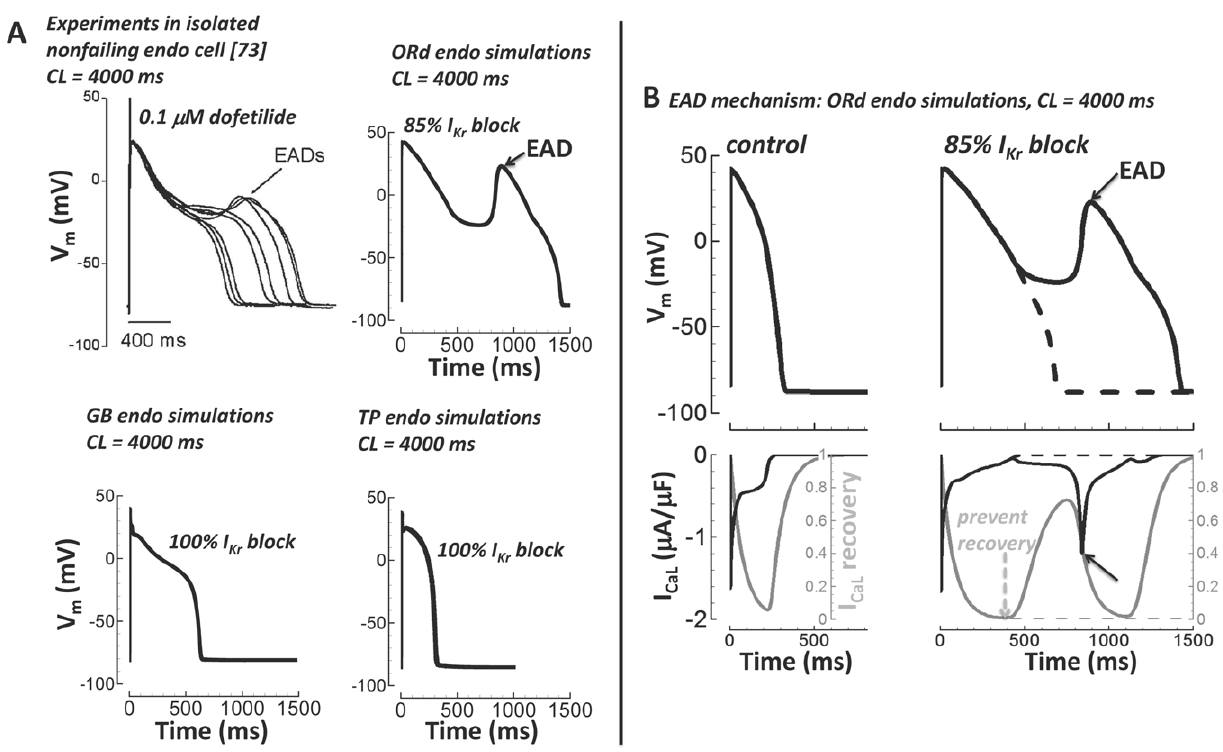
Figure 11. Early afterdepolarizations (EADs). A) Top left) Experiments in isolated nonfailing human endo myocytes from Guo et al.[73] showed EADs with slow pacing (CL=4000 ms) in the presence of I Kr block (0.1 m M dofetilide, , 85% I Kr block[74], reproduce with permission). Top right) Following the experimental protocol of Guo et al. (CL=4000 ms, 85% I Kr block) the ORd model accurately showed a single large EAD. Bottom) GB (left) and TP (right) models failed to generate EADs (CL=4000 ms, even with 100% I Kr block). B) EAD mechanism. APs are on top. I CaL (black) and I CaL recovery gate (gray) are below. Slow pacing alone (CL=4000 ms) did not cause an EAD (left). Slow pacing plus I Kr block (85%) caused an EAD (solid lines, right). The EAD was depolarized by I CaL reactivation during the slowly repolarizing AP plateau (solid lines, solid arrows). When I CaL recovery was prevented, the EAD was eliminated (dashed lines and dashed arrow).